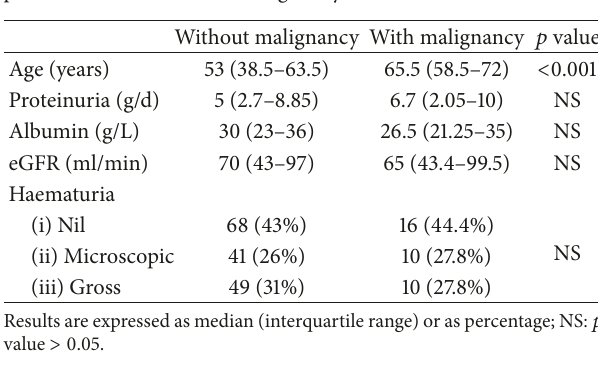
Table 1: Cohort characteristics at time of MN diagnosis. Table 2: Clinical and laboratory data at time of kidney biopsy in patients with and without malignancy.